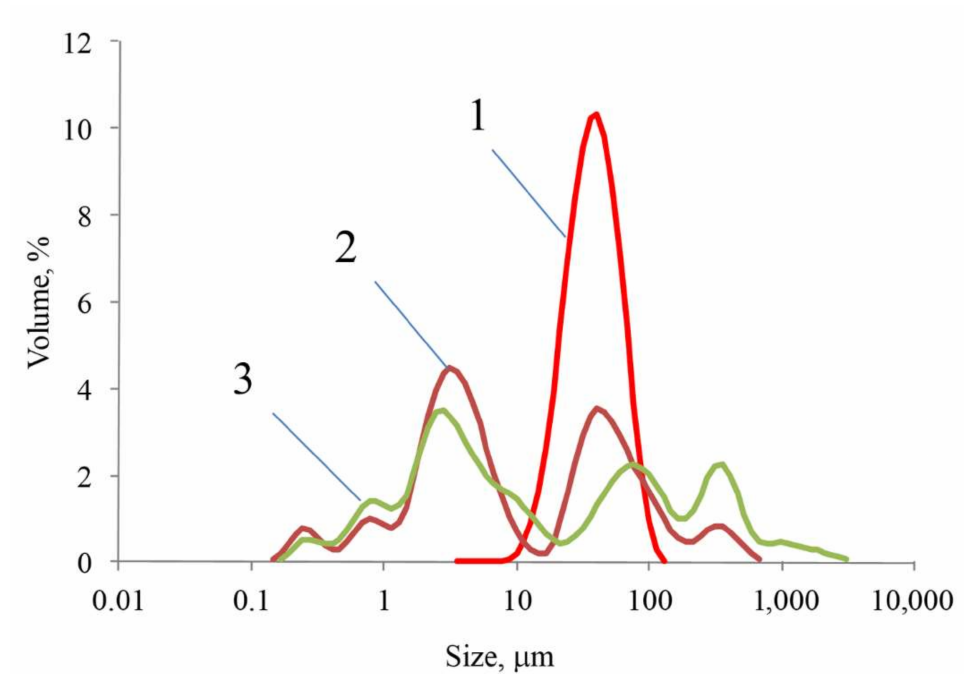
Figure 7. Particle size distribution upon chitosan condensation from acid solutions: (1) acetic acid; (2) oxalic acid; (3) citric acid.